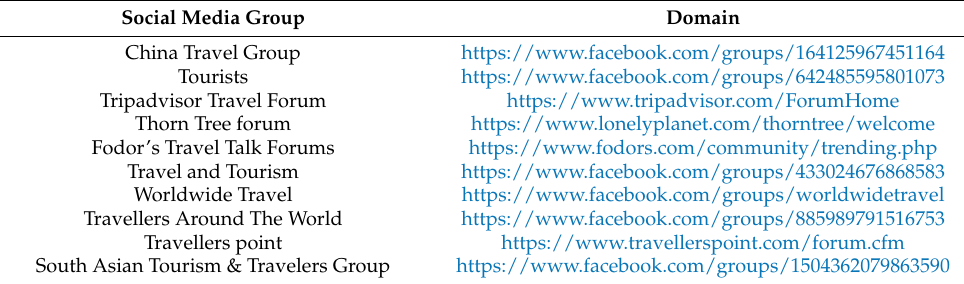
Table 1. List of social media groups from where participants were recruited.